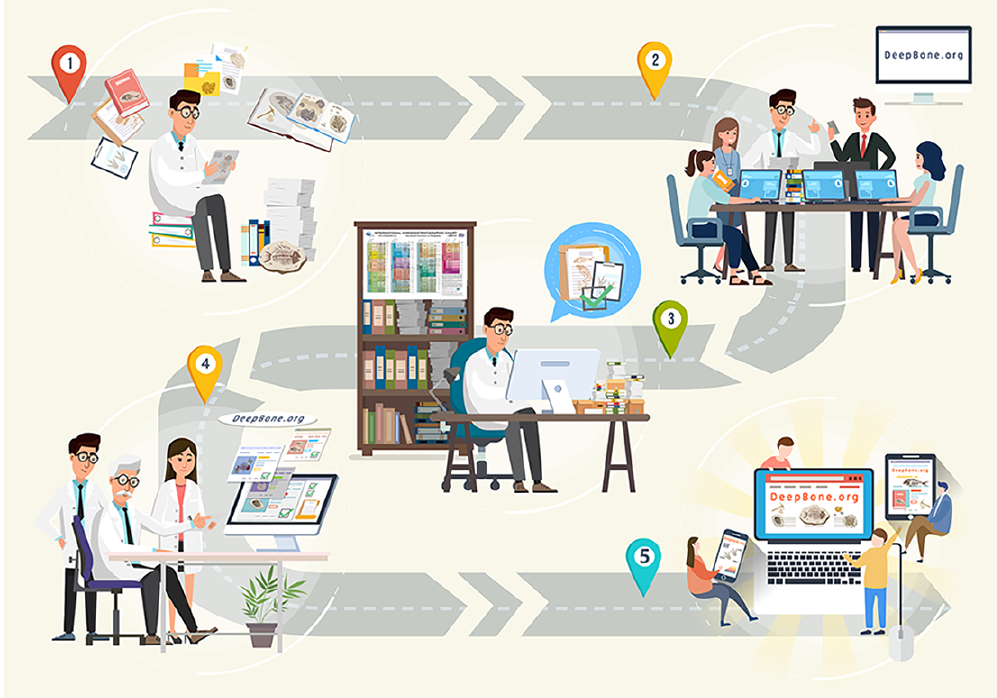
Figure 2. Workflow of the data processing. (1) Collecting and sifting lectures by experienced experts. (2) Data entry assistants digitalize paleontological descriptions from the page into the DeepBone database. (3) According to the reference, experts are accountable for data review and cleaning to implement quality control. (4) Senior researchers review the data again. (5) Data managers release the data to the public through DeepBone.org (http://DeepBone.org, last access: 22 October